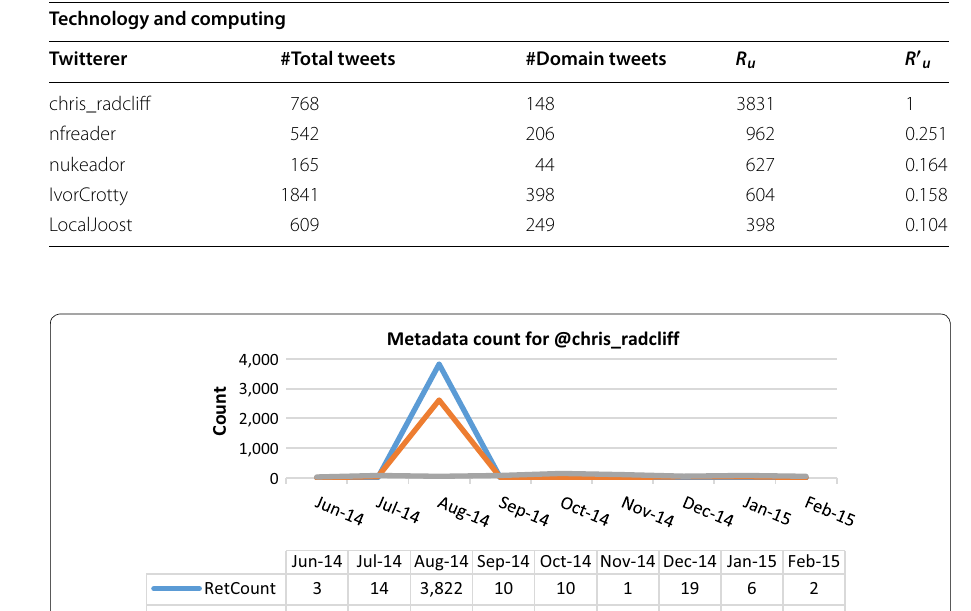
Table 2 Domain-based user retweets R u,d